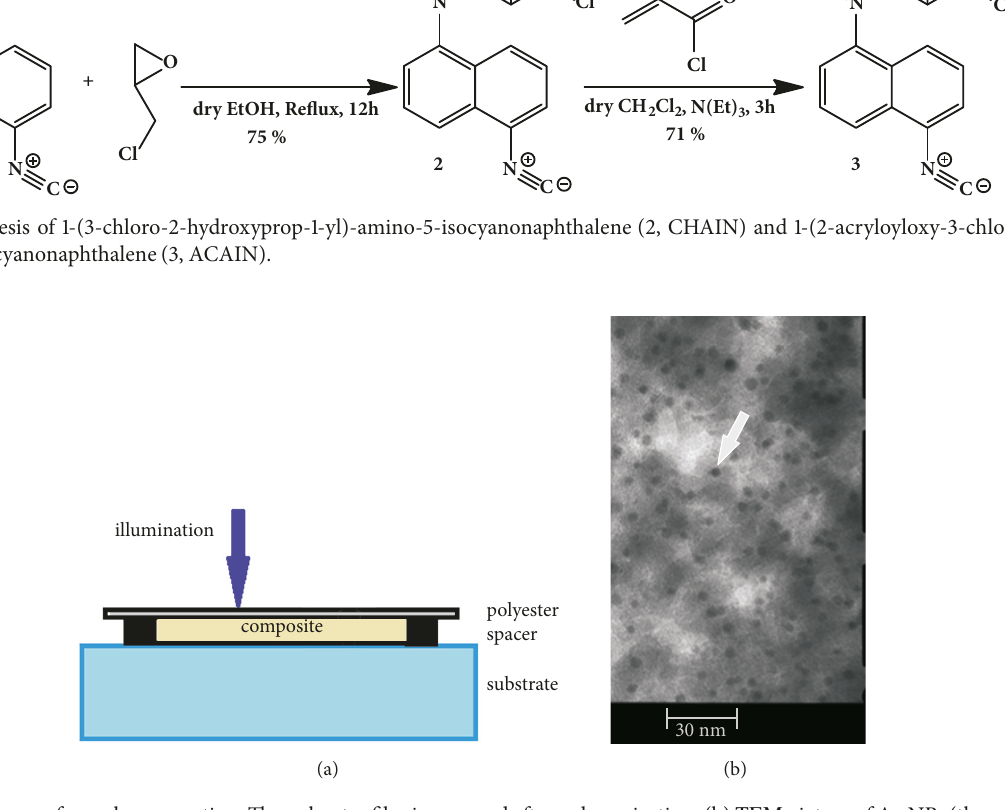
Figure 3: (a) Scheme of sample preparation. The polyester film is removed after polymerization. (b) f@V picture of Au NPs (the white arrow selects one) in the polymer matrix, Sample